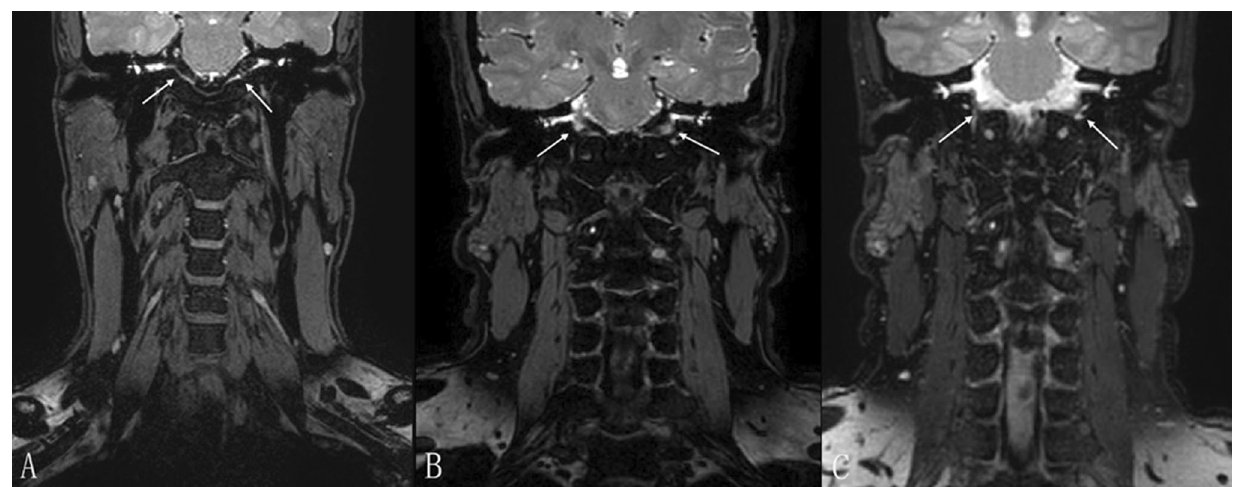
Figure 3. Examples of different grading scales of flow suppression in the cerebellopontine angle region (arrow). ( A ) Most flow suppression (grade 3) presented on 3D T2-weighted fast field echo (3D_T2_FFE). ( B ) Partial flow suppression (grade 2) presented on 3D_T2_FFE. ( C ) No flow suppression (grade 1) presented on 3D_T2_